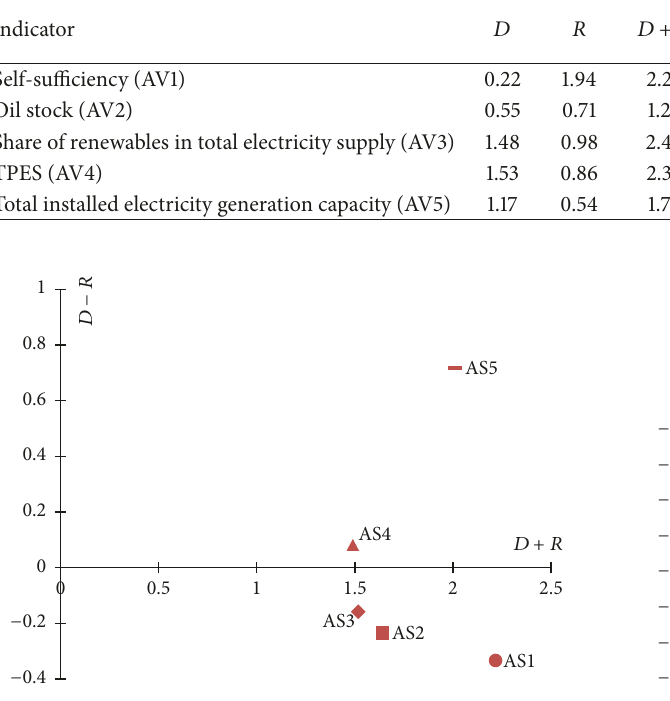
Figure 9: Cause-effect relationship diagram for Acceptability (Case 2 ).